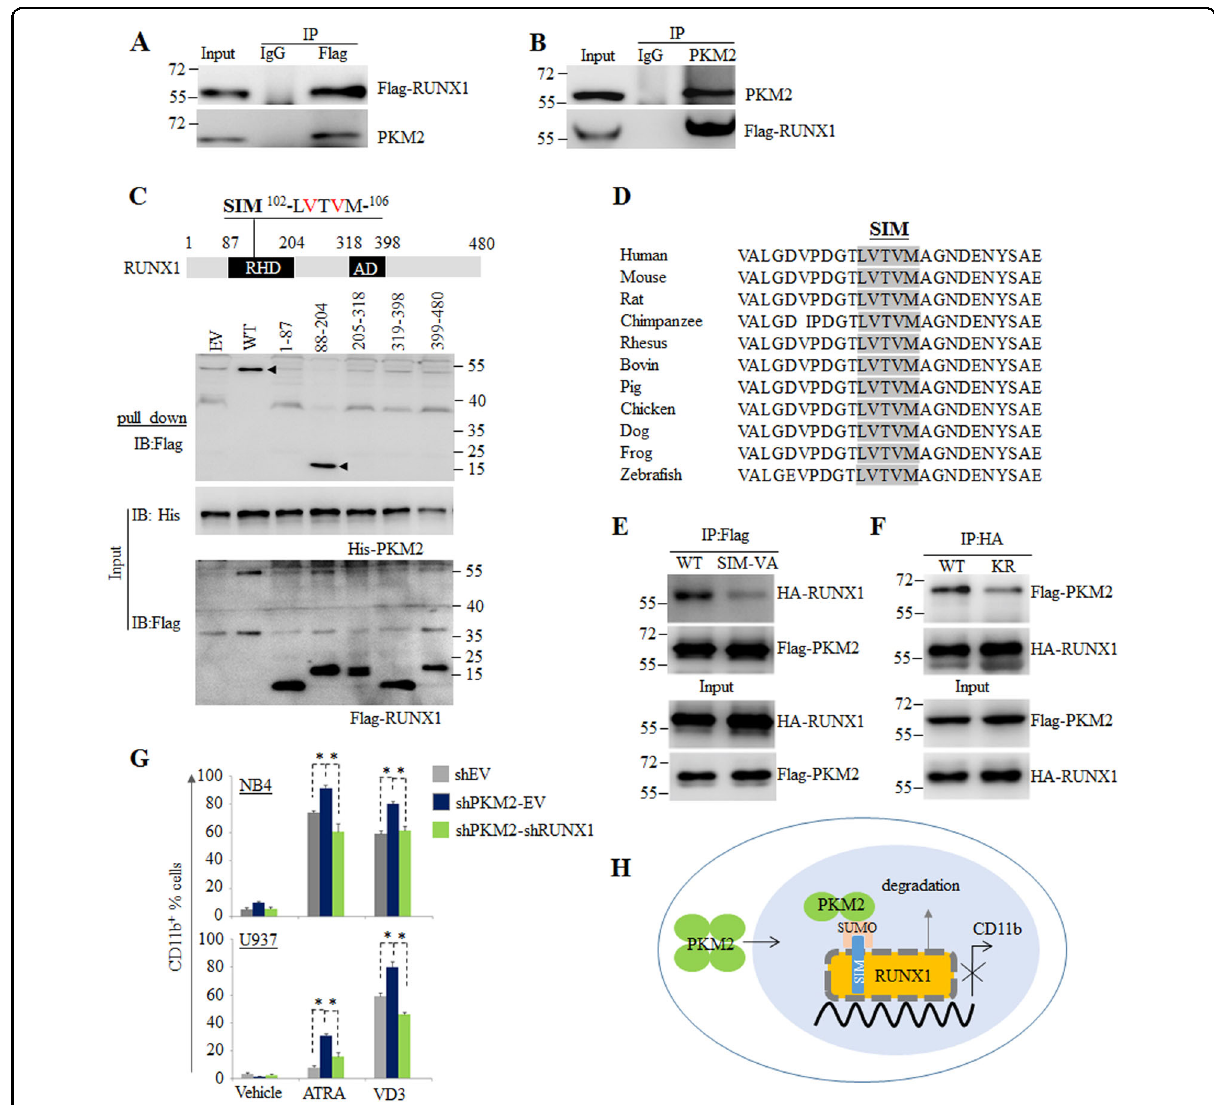
Fig. 6 SUMOylation mediates interaction between PKM2 and RUNX1. A , B IP assay was conducted using antibodies against Flag ( A ) or PKM2 ( B ) in NB4 cells ectopically expressed Flag-tagged RUNX1. C IP analysis of interaction between PKM2 and RUNX1 subunits containing the indicated amino acid residues using His-tagged PKM2 and Flag-tagged RUNX1 prepared from NB4 cells. Full-length (WT) or the truncated segments were illustrated by structure schematic diagram. RHD runt-homology domain, AD activation domain, SIM SUMO-interacting motif. The indicated valines (V) in red within the SIM were mutated to alanines ( A ) in the mutants SIM-VA. D Sequence alignment of SIM in RUNX1 among different species. E WT or SIM-VA mutant RUNX1 were co-expressed with Flag-PKM2 in NB4 cells and IP assay was performed using anti-Flag antibody. F WT or K270R mutant PKM2(KR) mutant were co-expressed with HA-RUNX1 in NB4 cells and IP assay was performed using anti-HA antibody. G NB4 and U937 cells were infected with CRISPR-Cas9 system targeting PKM2 followed by knocking down RUNX1 with shRNA and treated with ATRA or VD3. The CD11b- positive cells were counted by fl ow cytometry. * P < 0.05 between the line-pointed group. Data are shown as the mean ± SEM of three independent experiments. H SUMOylation of PKM2 dissembles tetrameric PKM2 to dimeric form and induces nuclear translocation where PKM2 promotes degradation of RUNX1, thus blocks the transcription of myeloid associated gene